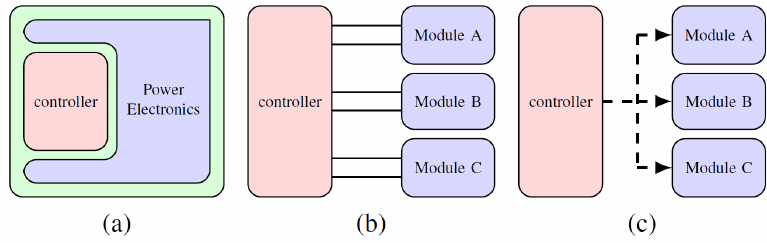
Figure 1. Different modular drive configurations: ( a ) Single Inverter; ( b ) Direct Gate driving; and ( c ) Distributed Gate Driving solid lines represent direct gate connections, dashed arrows represent communication